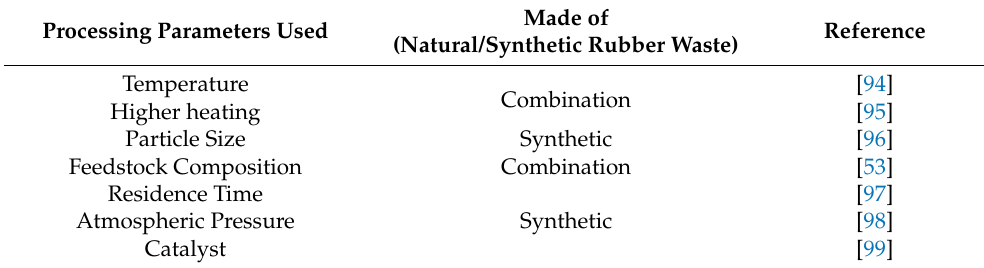
Table 3. Effects of pyrolysis processing parameters on fuel-additive production from rubber waste. Processing Parameters Used